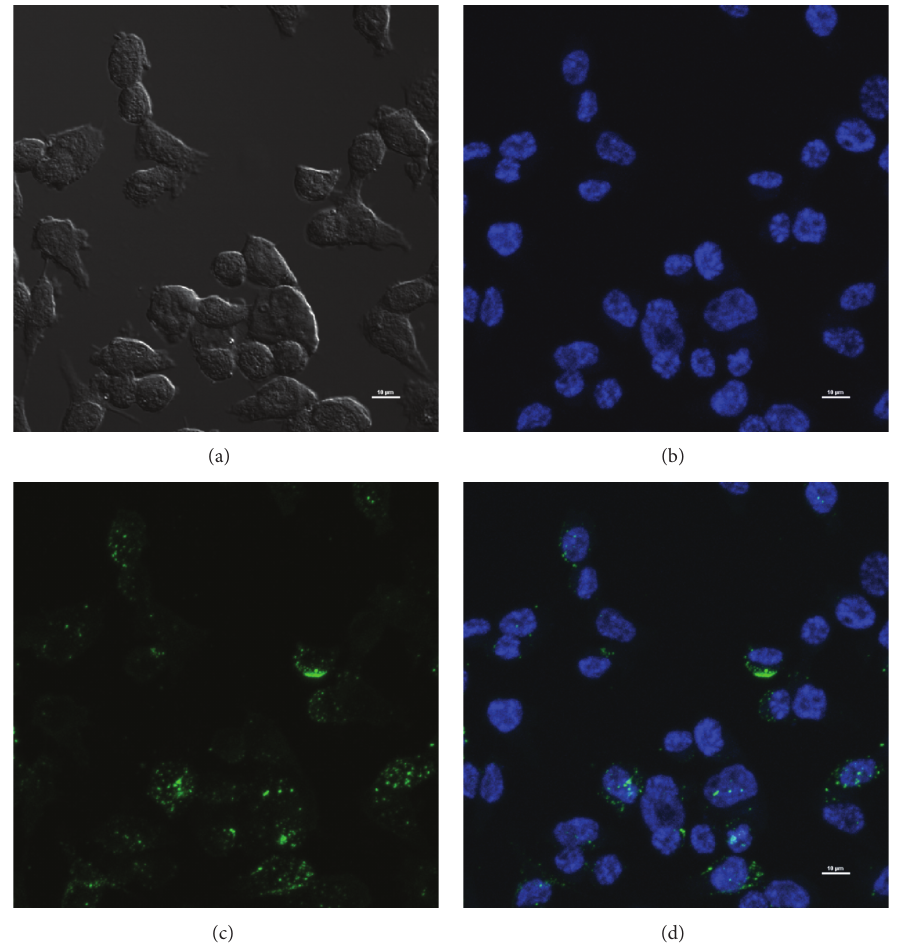
Figure 6: Cellular uptake study using BT-47 4 cells. Cells were plated and allowed to adhere for 24 hours, after which nCaP CMHA - AF488 EMT was added at a concentration of 2mg/mL. After 18 hours, nCaP CMHA - AF488 can clearly be seen within cells as confirmed by Z-stack confocal images. (a) Differential interference contrast (DIC) image, (b) cells stained with DAPI, (c) cells imaged containing nCaP CMHA - AF488 , and (d) overlay of DAPI and AF488 images, showing nCaP CMHA - AF488